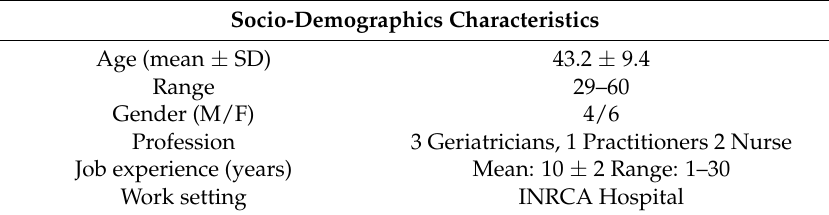
Table 2. Participants